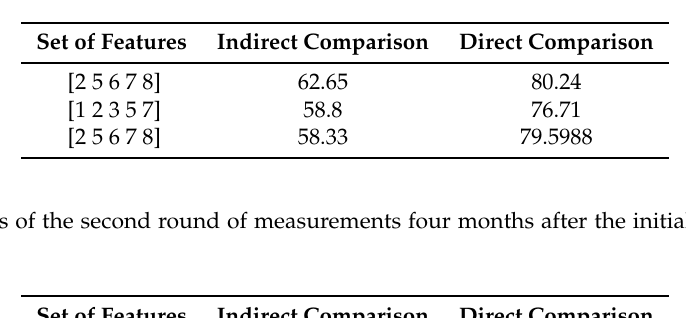
Table 2. Results of the second round of measurements four months after the initial ones. Data for Gyroscope X.